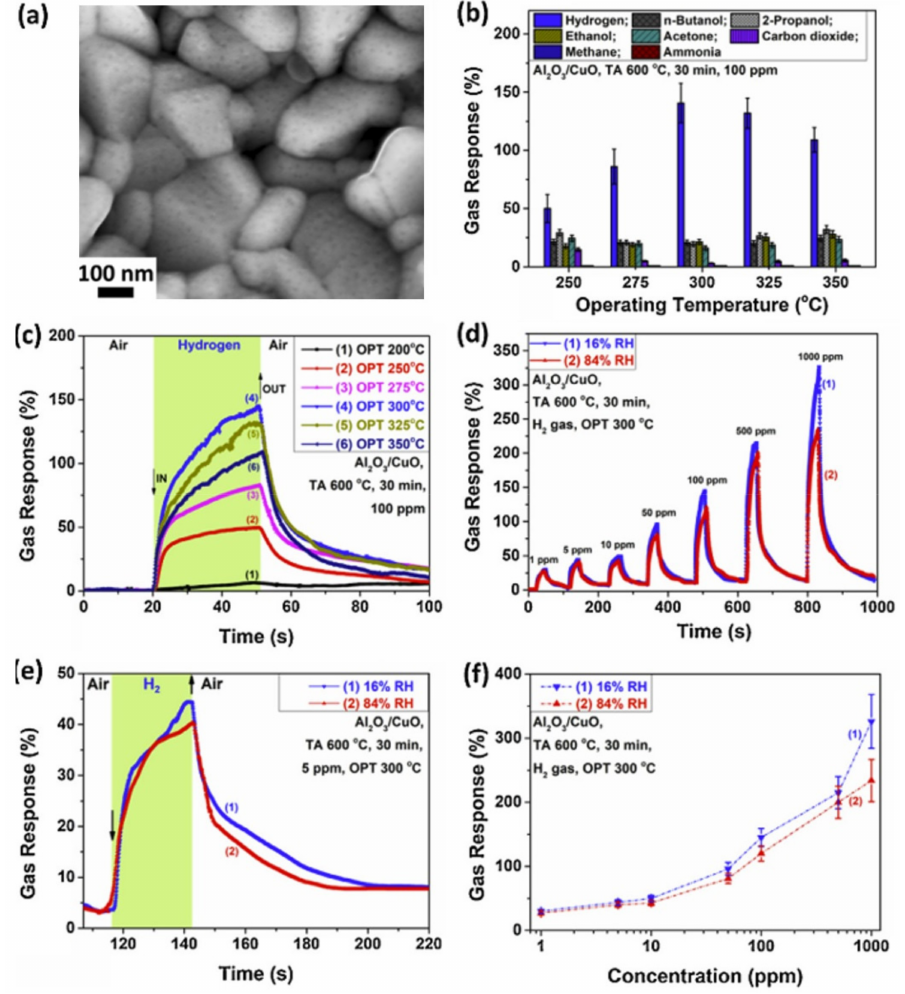
Figure 17. ( a ) SEM image of CuO/Al 2 O 3 heterostructure with thermal annealing (TA) at 600 °C for 30 min. ( b ) Responses towards different gases have the same concentration (100 ppm) versus different operation temperatures (OPT). ( c ) Dynamic response of CuO/Al 2 O 3 heterostructure at different working temperatures. ( d ) Dynamic response of CuO/Al 2 O 3 heterostructure towards various H 2 concentrations ranging from 1 ppm to 1000 ppm at different humidity levels. ( e ) Dynamic response of CuO/Al 2 O 3 heterostructure towards 5 ppm of H 2 at different humidity levels. ( f ) Response (%) versus different concentrations of CuO/Al 2 O 3 heterostructure at 300 °C. Reprinted with permission from